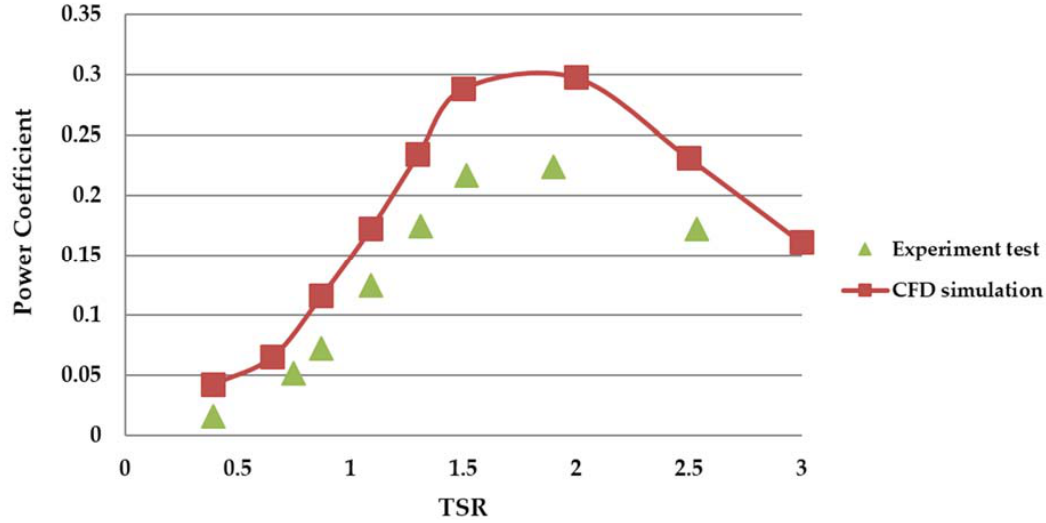
Figure 15. Results of the coefficient of the power in wind tunnel experimental test data compared to the CFD simulation.